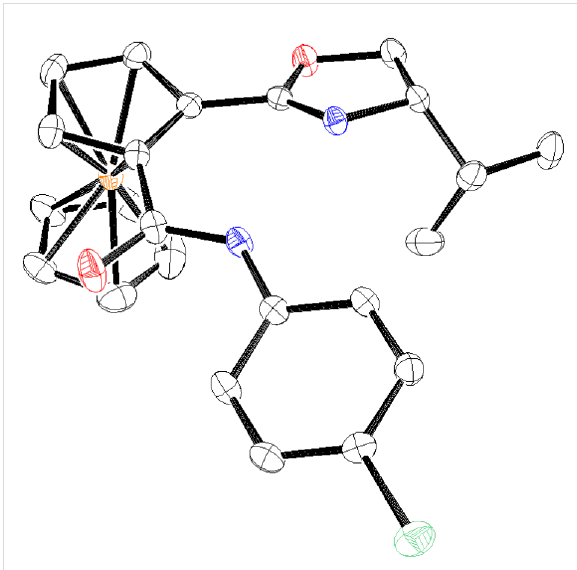
Figure 1: The ORTEP drawing of 3c with 30% probability ellipsoids, and Flack absolute structure parameter of